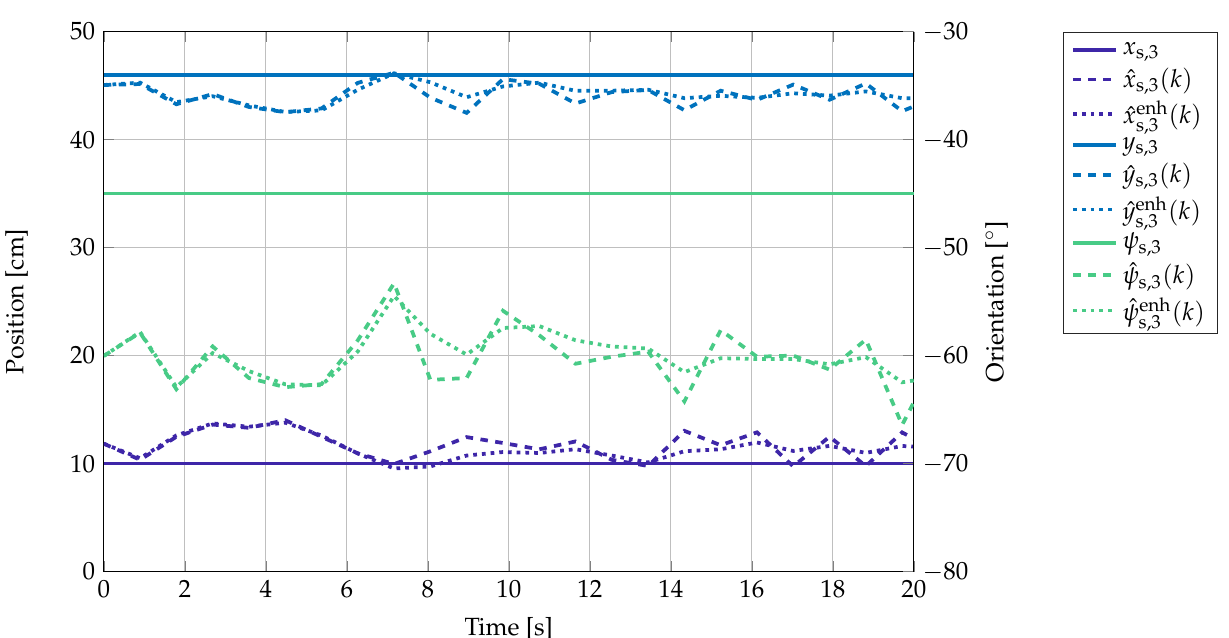
over time. The variances in the localization result are due to the presence s,3